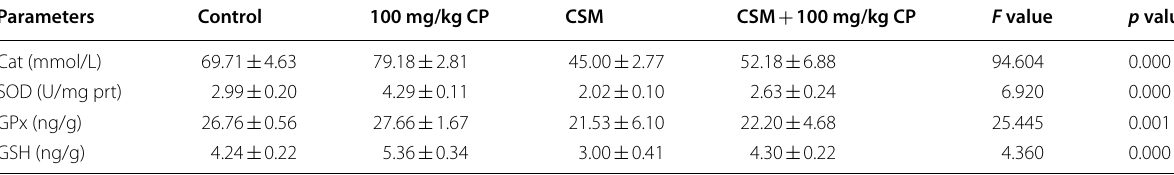
Values are mean standard deviation (mean dismutase, GPX glutathione peroxidase, GSH glutathione, CP Cissus populnea , CSM cotton seed meal